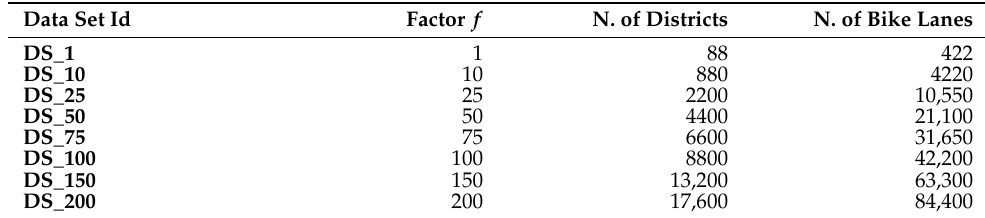
Table 2. Data sets used for analyzing scalability. Data Set